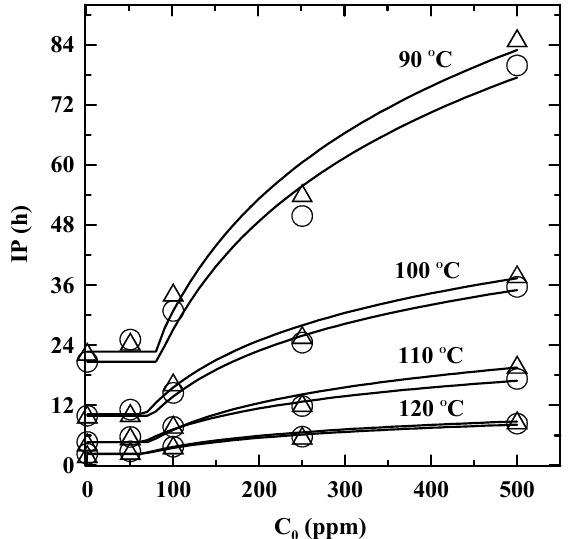
Figure 2. The variations of IP with C for the SNME and FFA-based biodiesel blend at 0 90 °C, 100 °C, 110 °C, and 120 °C, as determined by Rancimat method with the addition of PDA. Symbol, line: experimental data, prediction. ○ and Δ : EN 14,112 and EN 15,751, respectively.